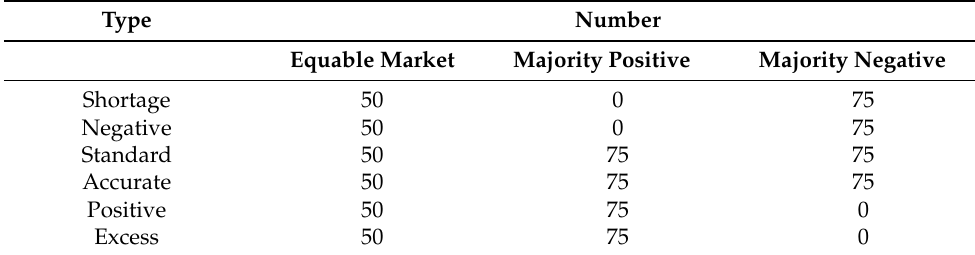
Table 3. The types and numbers of consumers in each